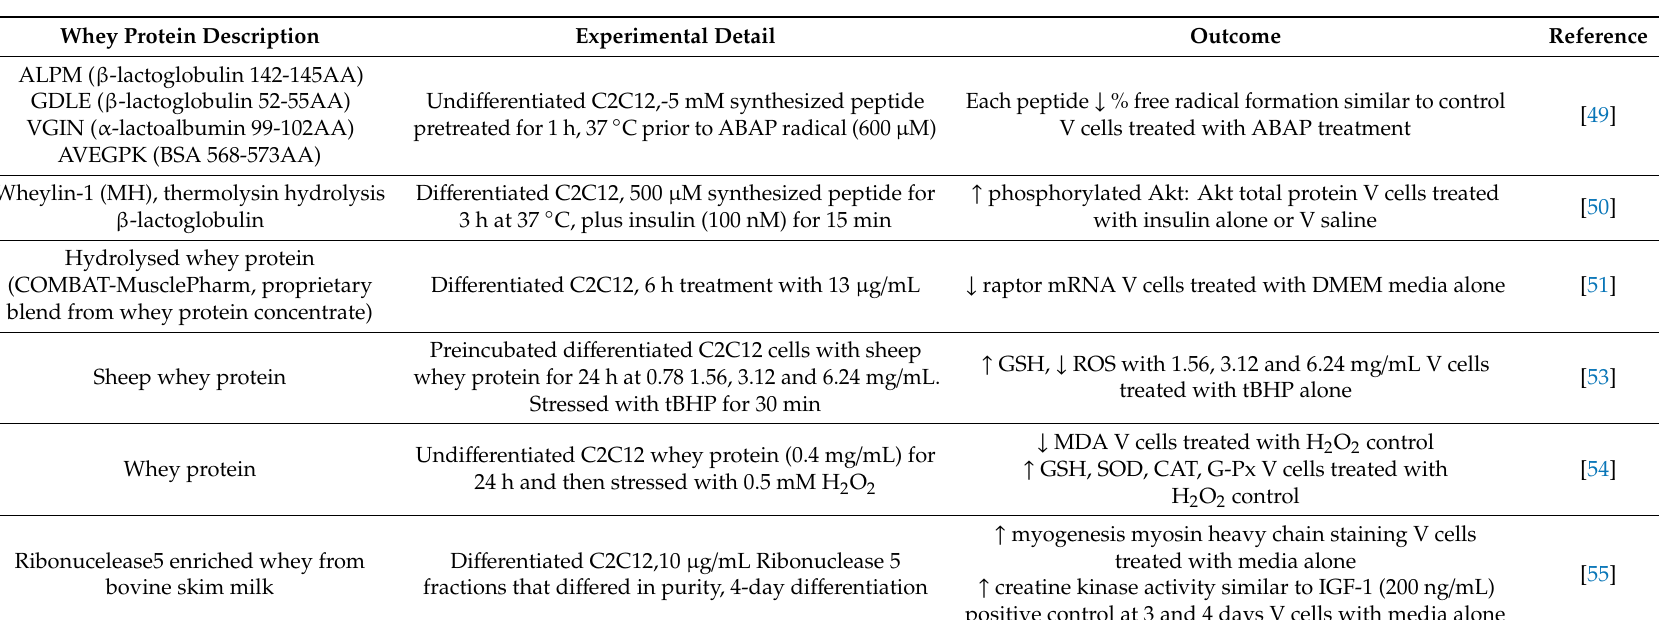
Table 1. E ff ects of whey protein supplementation on muscle cells in vitro. BSA: Bovine serum albumin; ABAP: 2,2 (cid:48) -azobis(2-methylpropionamidine) dihydrochloride; Akt: protein kinase B; DMEM: Dulbecco’s Modified Eagle Medium; tBHP: tert-butyl hydroperoxide; GSH: glutathione; ROS: reactive oxygen species; H 2 O 2 :